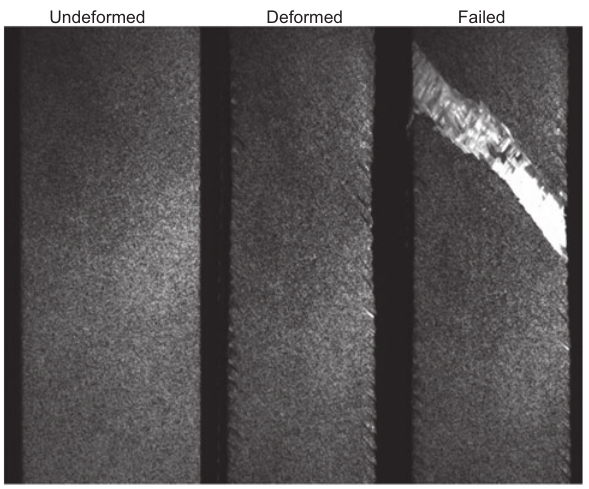
Figure 2 Test of 45 ° tension specimen with DIC strain